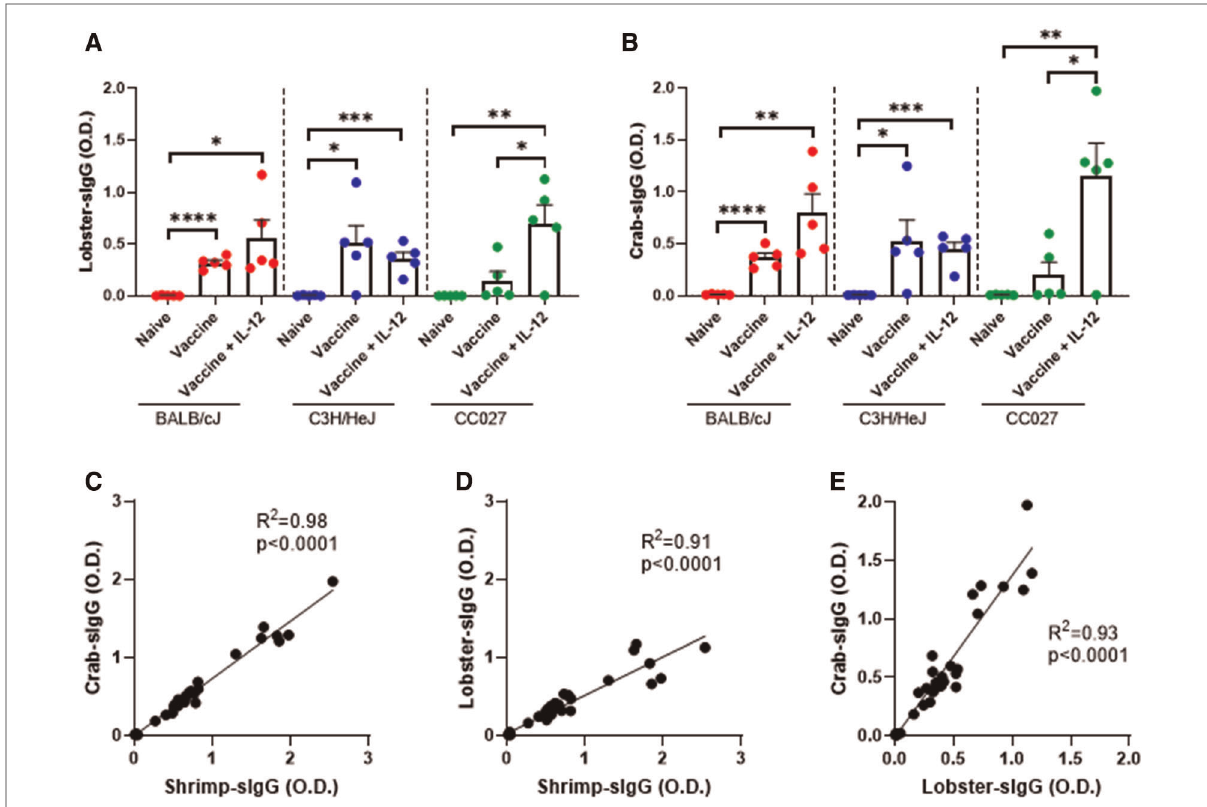
FIGURE 3 Lobster- and crab-speci fi c IgG responses following DNA vaccination with Gene Gun. ( A ) Lobster-speci fi c IgG and ( B ) Crab-speci fi c IgG in naïve and vaccinated BALB/cJ, C3H/HeJ and CC027 mice. Correlations between ( C ) shrimp- and crab-speci fi c IgG responses, ( D ) shrimp- and lobster-speci fi c IgG responses, and ( E ) lobster- and crab-speci fi c IgG responses in BALB/cJ, C3H/HeJ, and CC027 mice. Statistical comparisons were made using unpaired t tests; * p <0.05, ** p <0.01, *** p <0.001, **** p <0.0001. Linear regression analyses were performed on the correlation